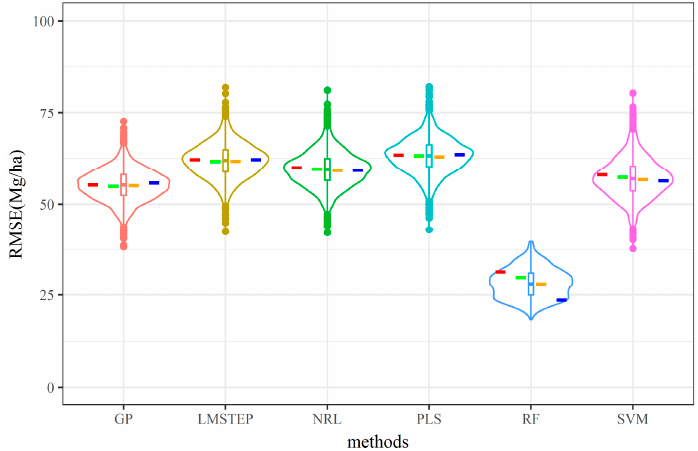
Figure 5. The distribution of RMSE values using different prediction approaches.